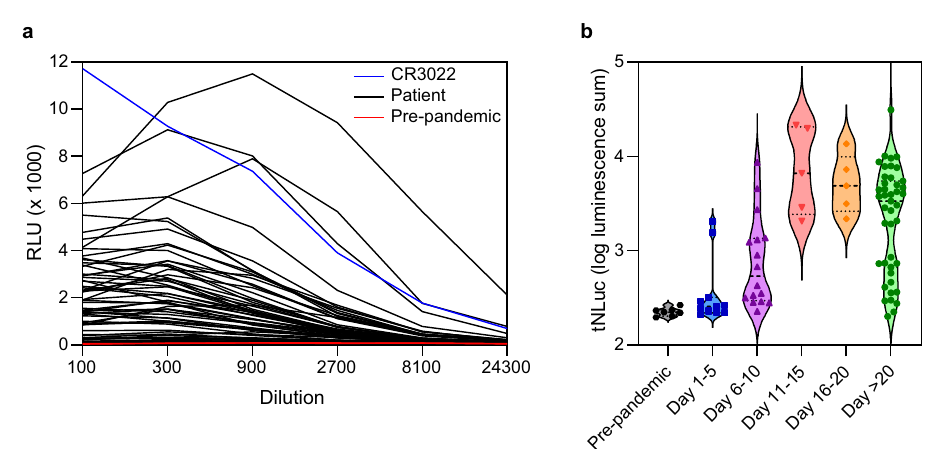
Fig. 3 Detection of α -SARS CoV-2 antibody in serum samples with the SATiN assay. a Samples included 7 (red) collected before the pandemic and 82 (black) from veri fi ed active or convalescent COVID-19 patients collected at different times after symptom onset. These were serially diluted as indicated and subjected to SATiN testing. CR3022 (0.4 mg/mL in stock, red) was used as positive control. The level of anti-SARS CoV-2 antibodies at each dilution measured using SATiN. Data shown here are a representative result of two independent experiments with similar results. b . The overall antibody signal in each sample was calculated by summation of luminescence signals at dilutions 1:300, 1:900, and 1:2700. Samples are categorized in groups based on time elapsed between symptom onset and sample collection, and their distribution is presented in violin plots. The central dashed lines represent medians. Source data are available in the Source Data fi